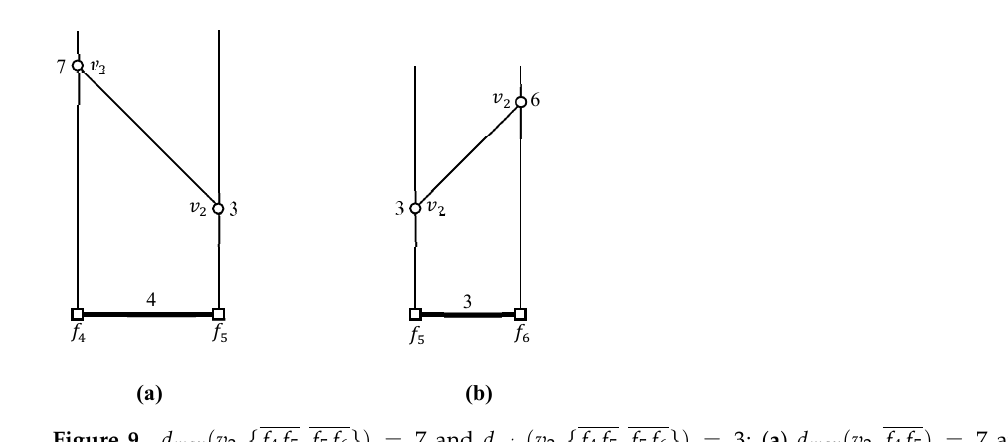
Figure 9. d max ( v 2 , { f 4 f 5 , f 5 f 6 } ) = 7 and d min ( v 2 , { f 4 f 5 , f 5 f 6 } ) = 3; ( a ) d max ( v 2 , f 4 f 5 ) = 7